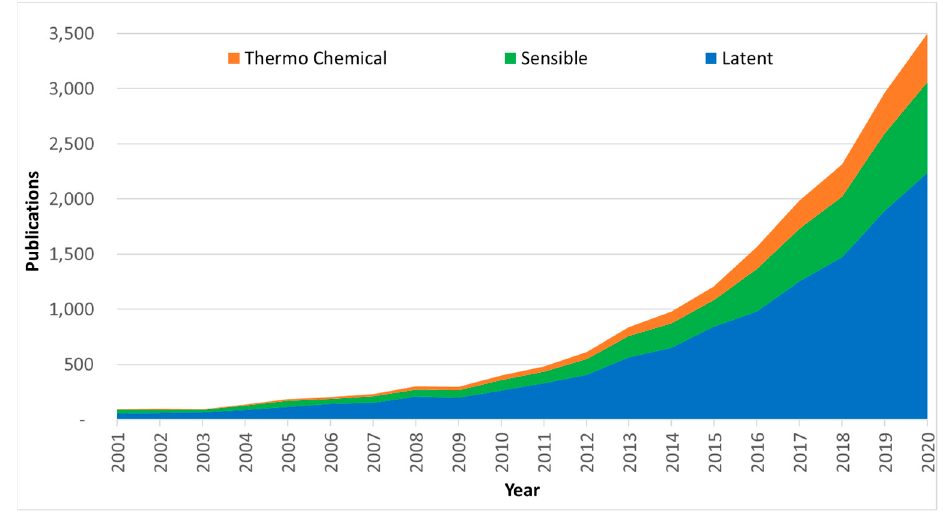
Figure 6. Publications evolution classified per thermal energy storage technology types, over the last two decades.